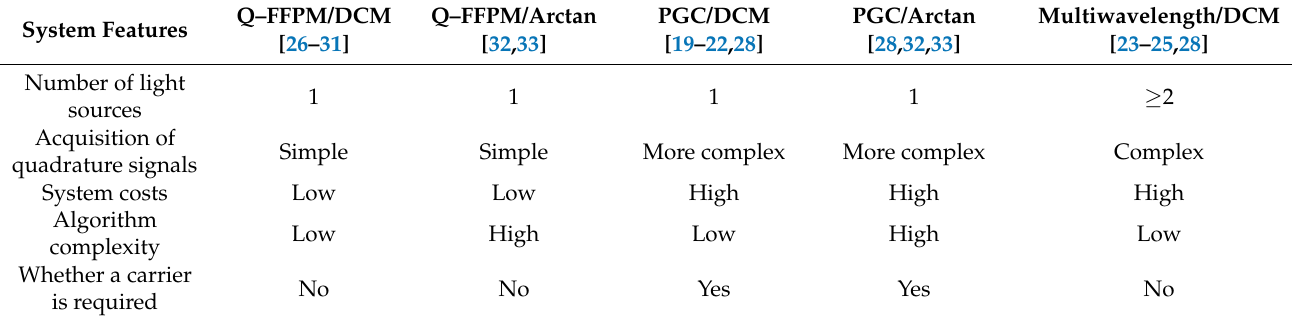
Table 1. Quadrature signal acquisition and demodulation scheme